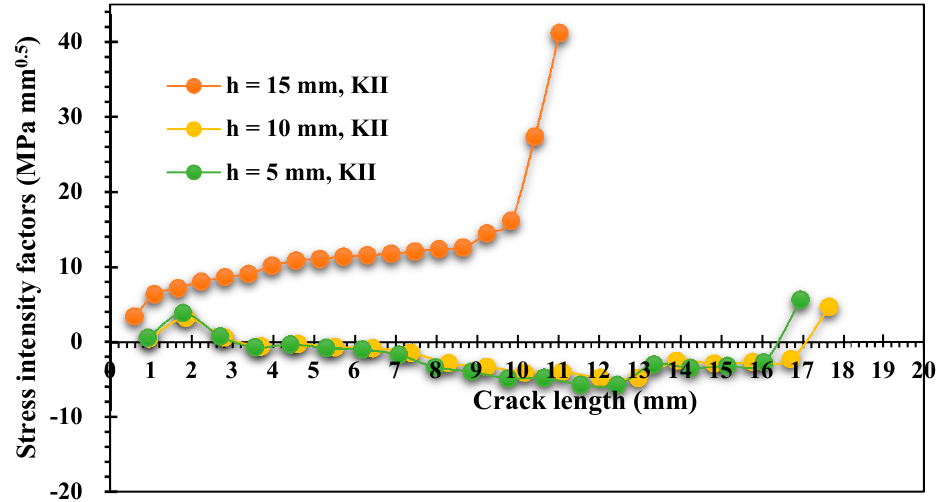
Figure 15. Evaluated results of K II for three pre-crack positions.